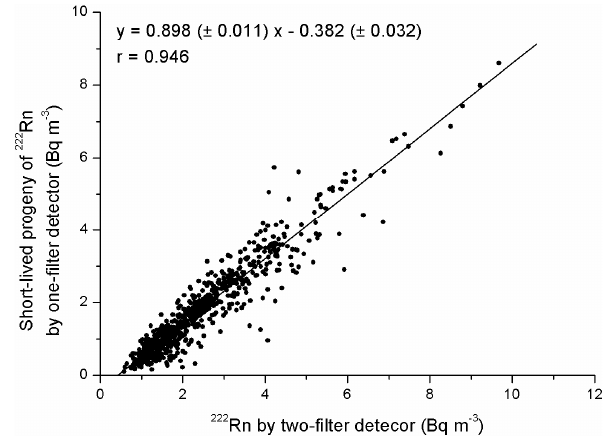
Fig. 4. Average altitude of air masses (ensemble means of single particle trajectories) during the 24h before arrival at the station for the lowest (0–25th) to the highest (75th–100th) quartile of observed 222 Rn activity concentrations.